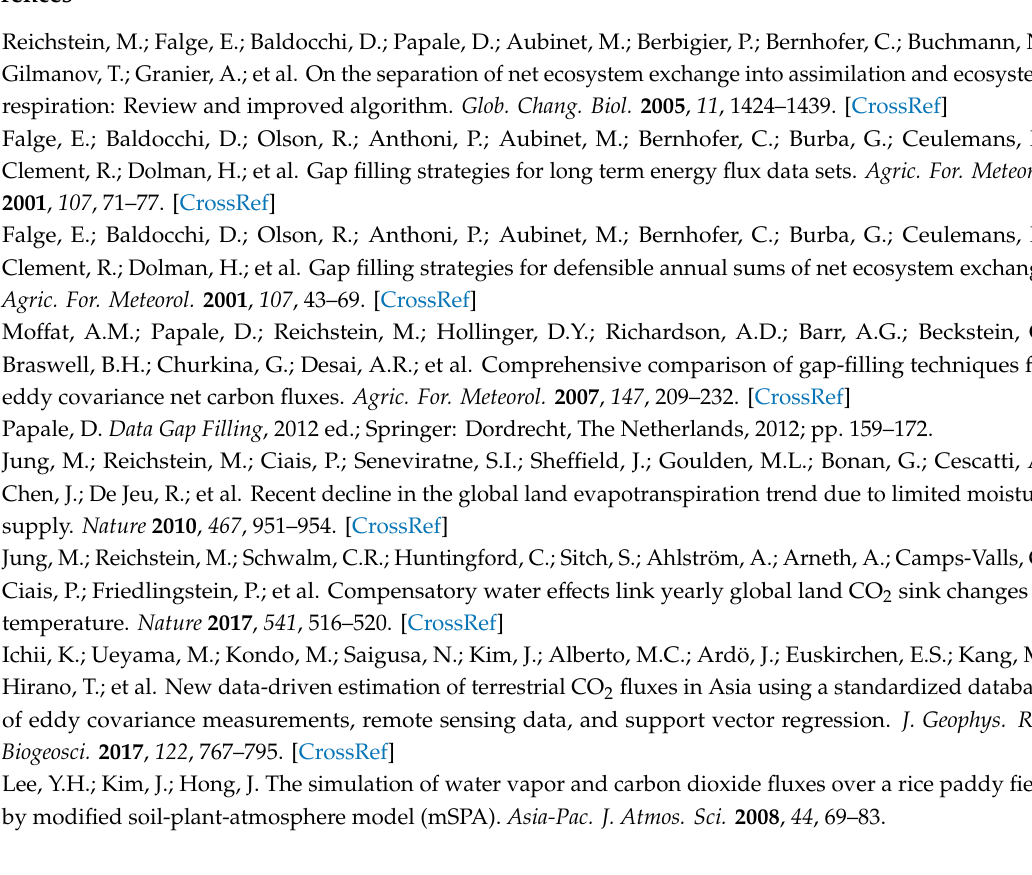
Figure S1: Time series of daily downward shortwave radiation ( R sdn , a ), daytime air temperature ( T air , b ), daytime vapor pressure deficit (VPD, c ) and precipitation ( P , d ) at the flux tower, Figure S2: Time series of daily leaf area index (LAI, a ), enhanced vegetation index (EVI, b ), and land-surface water index (LSWI, c ) from the eight-day moderate resolution imaging spectroradiometer (MODIS) data products (MOD15A2 and MCD43A4 version 6) for the study site, Figure S3: Relationships between the length of the training dataset and the root-mean-square error (RMSE) for error assessment of Experiments 3-1, 3-2, 3-3, 3-4, 3-5, and 3-6 ( a : gross primary production, b : ecosystem respiration, c : net ecosystem exchange, d : evapotranspiration), Figure S4: Same as Figure S3 ( a :